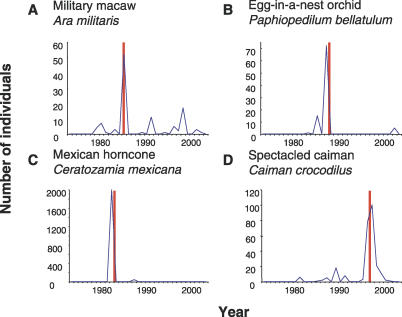
Illustration of the Increased Demand Associated with Perceived RarityVolumes of illegal trade of four species examples [a bird (A), two plants (B and C), and a reptile (D)], which have undergone a change in CITES status. The year that the change in status took effect is indicated by the red line.